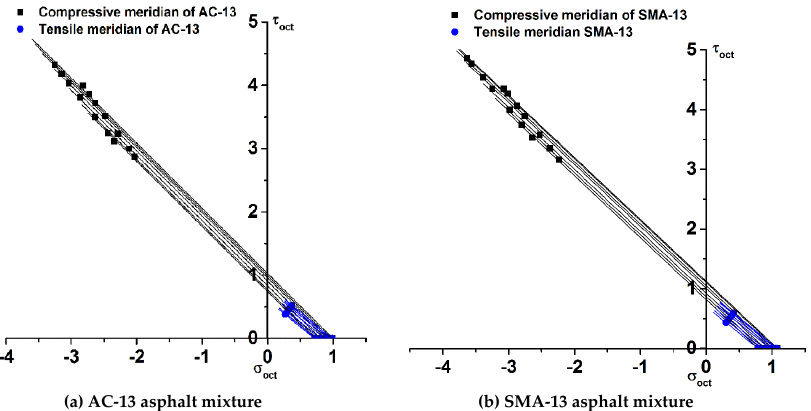
Figure 12. Tensile and compressive meridians of asphalt mixtures after freeze-thaw cycles. Note: The meridians from top to bottom represent the tensile and compressive meridians after 0, 1, 3, 5, 10, 15, and 20 freeze-thaw cycles, respectively.